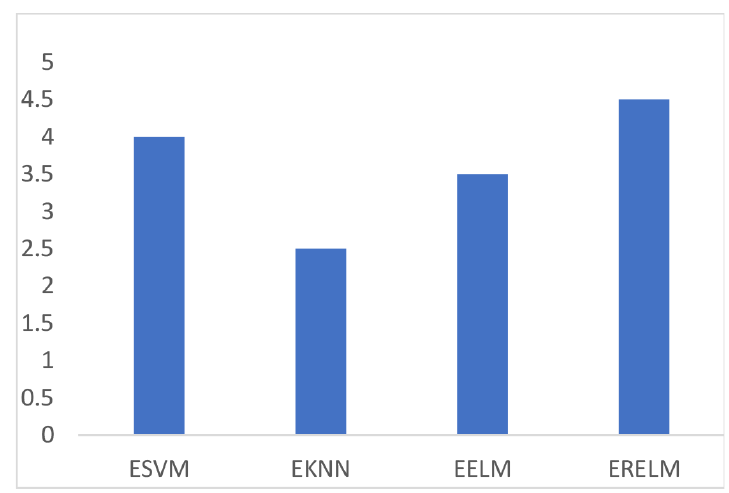
Figure 3. TPR of ERELM, ESVM, EELM, and